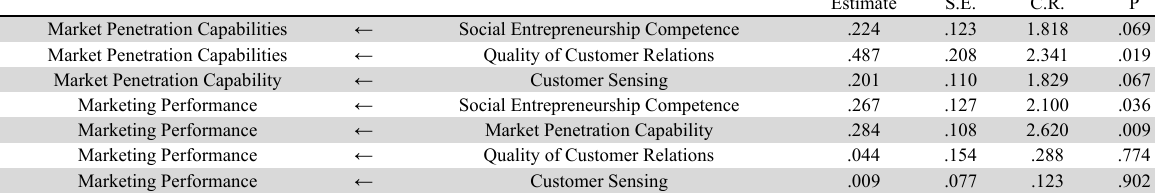
Regression Weight (Loading Factors) Measurement Model Full